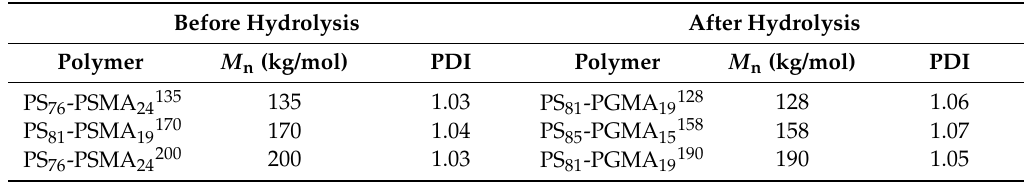
Figure 1. Route of synthesis for polystyrene- b -poly(solketal methacrylate) (PS- b -PSMA) and polystyrene- b -poly(glyceryl methacrylate) (PS- b -PGMA) by sequential anionic polymerization of styrene and isopropylidene glycerol methacrylate and subsequent hydrolysis. THF: tetrahydrofuran. Table 1. Characterization data of PS- b -PSMA and PS- b -PGMA diblock copolymers.